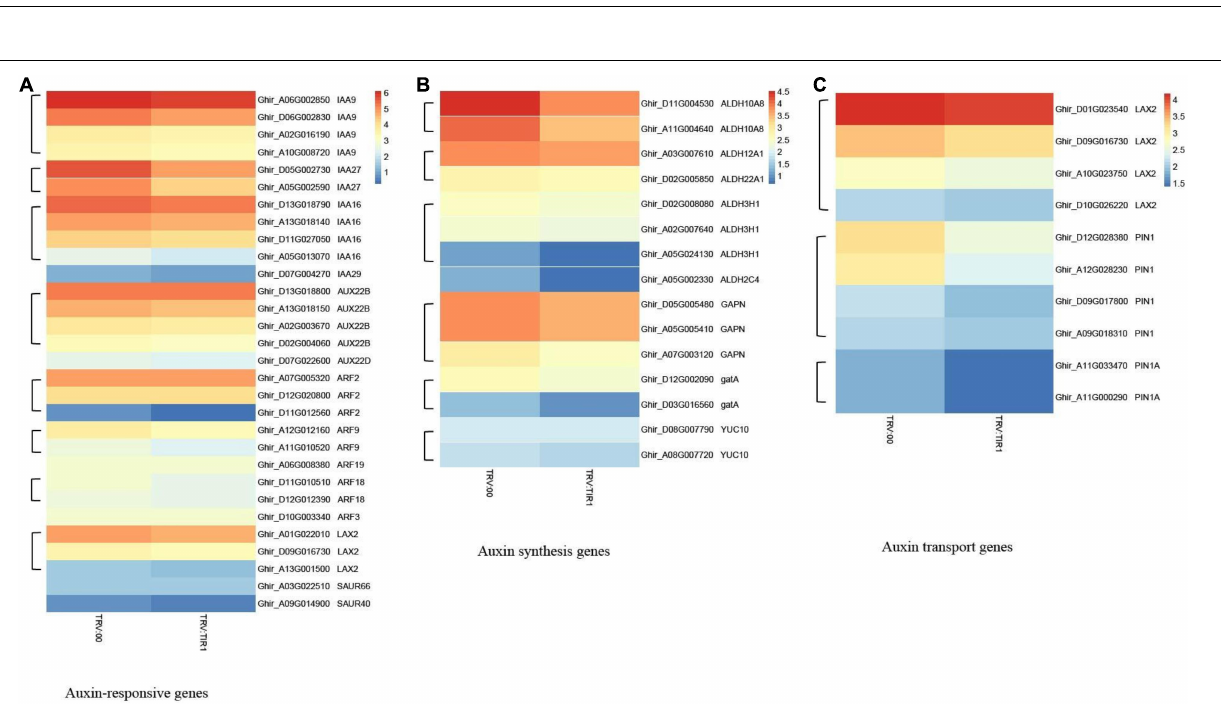
Frontiers in Plant Science |